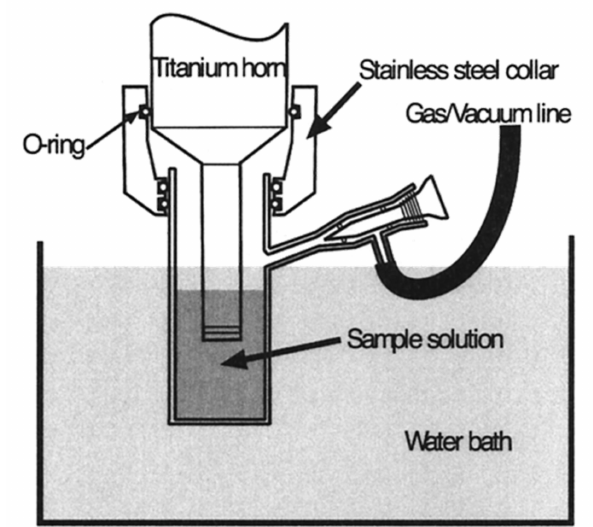
Figure 2. Schematics of the sonication reactor